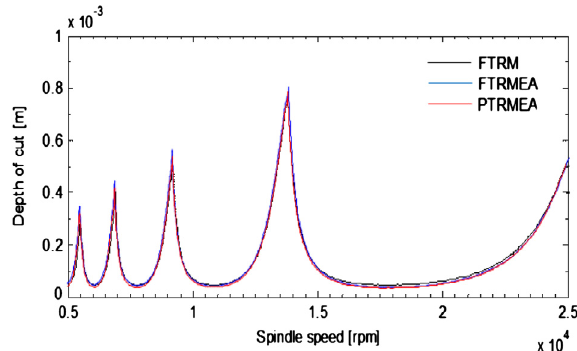
Figure 5. Stability lobes of fully-immersed 2DOF milling process using FTRM, FTRMPA and PTRMPA placed on same axes to show that the presented two types PA retain